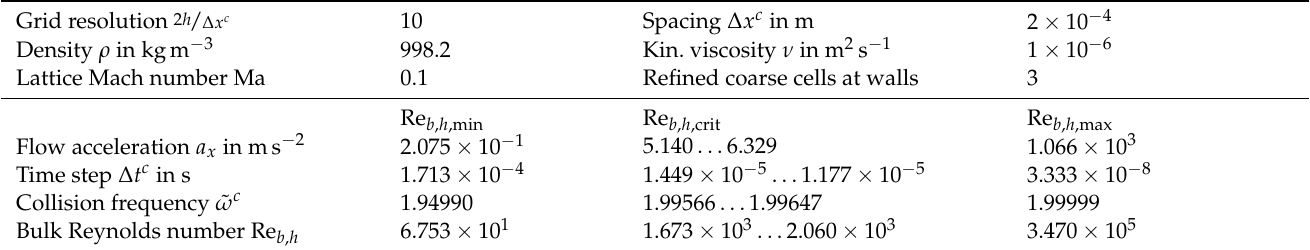
Table 1. Summary of simulation parameters. Top half: Constant parameters, bottom half: Changing parameters at lower and upper limit of investigated Reynolds number range as well as critical flow